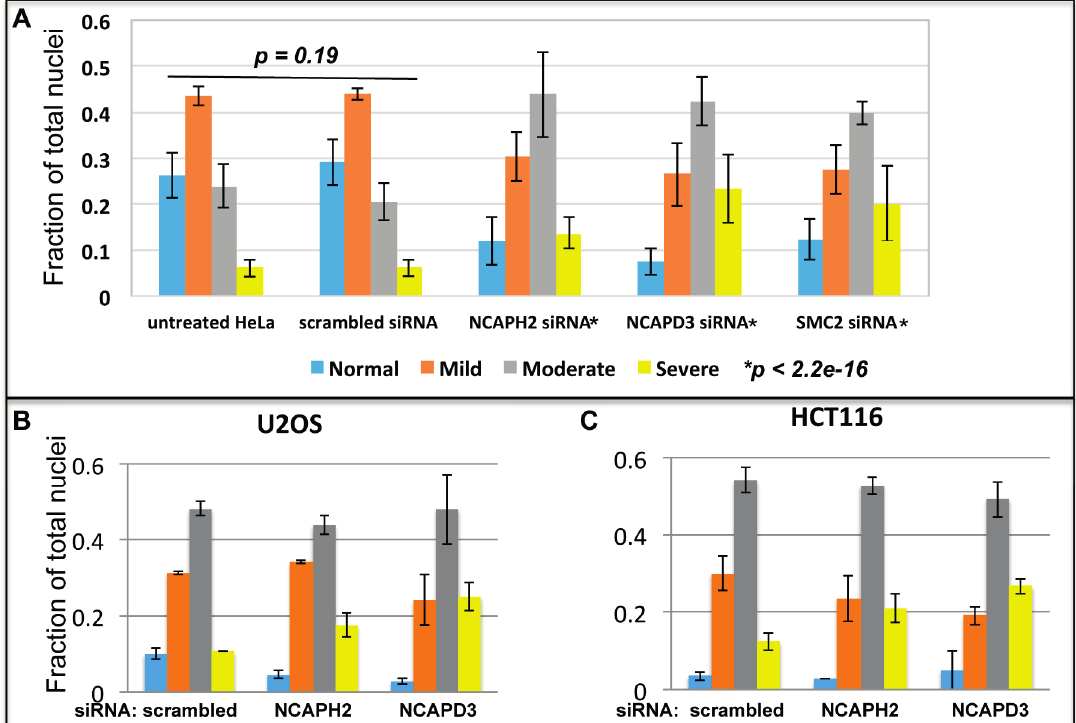
Figure 4. Condensin II is required for nuclear shape maintenance. ( A ) HeLa cells untreated, treated with scrambled siRNA or siRNA targeting NCAPH2, NCAPD3 or SMC2. Nuclei were scored blind and placed into four categories (as in Figure 3). Each represents the average of three or more independent experiments and error bars represent SEM. Distributions of nuclear shape for each treatment were compared to negative control siRNA (scrambled) using a chi-square goodness of fit test and p values are shown; ( B , C ) U20S and HCT116 cells treated with scrambled siRNA or siRNA targeting NCAPH2 and NCAPD3. In this experiment cells were also co-transfected with